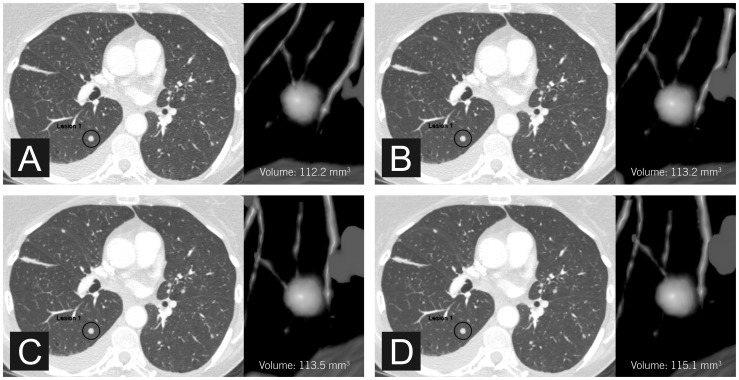
Axial CT images of a small pulmonary nodule.Measured volumes were 112.2 mm3 (A, FBP), 113.2 mm3 (B, iDose4 level 2), 113.5 mm3 (C, iDose4 level 4), and 115.1 mm3 (D, iDose4 level 6).